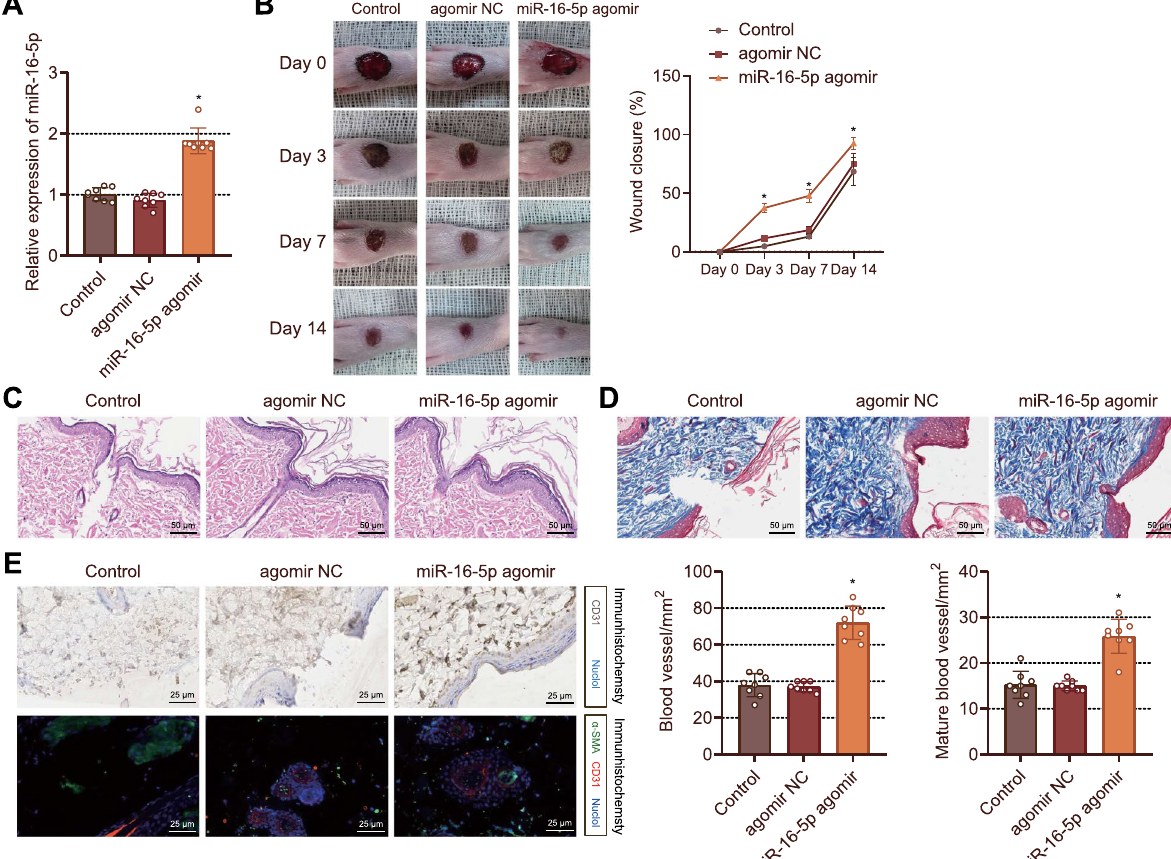
Fig. 2 miR-16-5p overexpression induces foot wound healing in DM rats. A RT-qPCR detection of the miR-16-5p expression in the foot wound tissues of DM rats treated with agomir NC or miR-16-5p agomir. * p < 0.05 vs. the agomir NC-treated rats. B Skin wound diameter changes in DM rats treated with agomir NC or miR-16-5p agomir. * p < 0.05 vs. agomir NC-treated rats. C Morphological and structural changes of foot wound tissues observed by HE staining. D Masson staining of collagen deposition in the foot wound tissues of DM rats treated with agomir NC or miR-16-5p agomir. E The number of newly formed and mature vessels in foot wounds of DM rats treated with agomir NC or miR-16-5p agomir assessed by immunohistochemical and immunofluorescent staining. * p < 0.05 vs. agomir NC-treated rats. n 8. Measurement data were presented as = mean standard deviation. Data among multiple groups were compared by one-way ANOVA, followed by Tukey’s post hoc test for multiple ± comparisons. Repeated measures ANOVA with Tukey’s post hoc test was applied for the comparison of data at different time